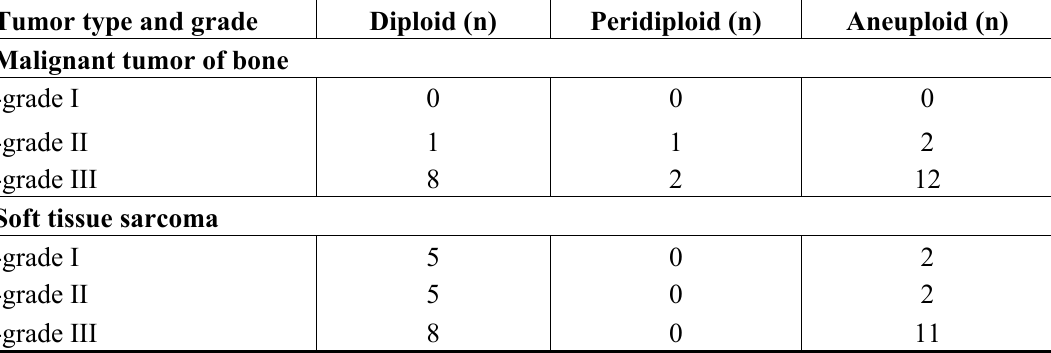
Table 2. DNA-ploidy status and histological malignancy grade in 59 sarcomas.